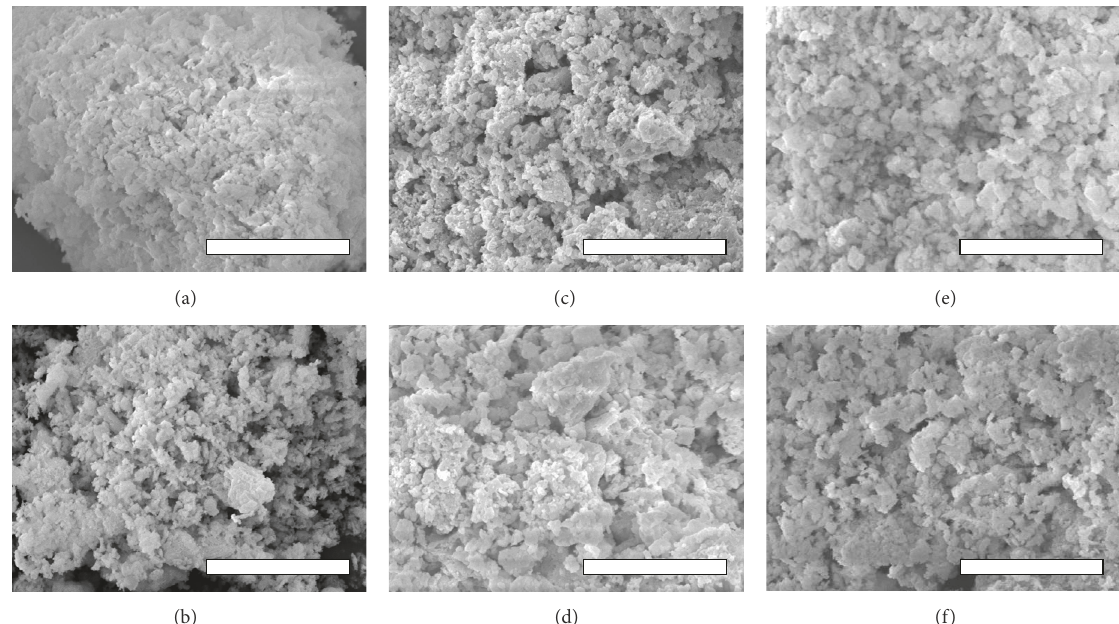
Figure 3: SEM images of the Pd-impregnated ceria catalysts. (a) 1Pd-CeO2-T-Cl, (b) 3Pd-CeO2-T-Cl, (c) 1Pd-CeO2-T-N, (d) 3Pd-CeO2-T-N,